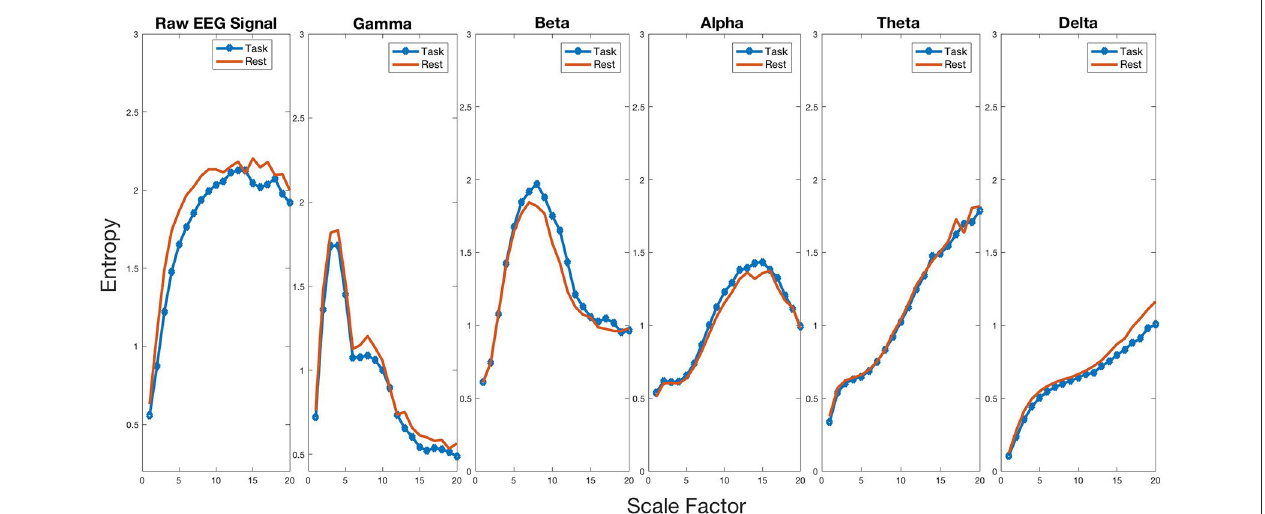
FIGURE 3 | Complexity profiles of the raw signal and all frequency bands for baseline and task.